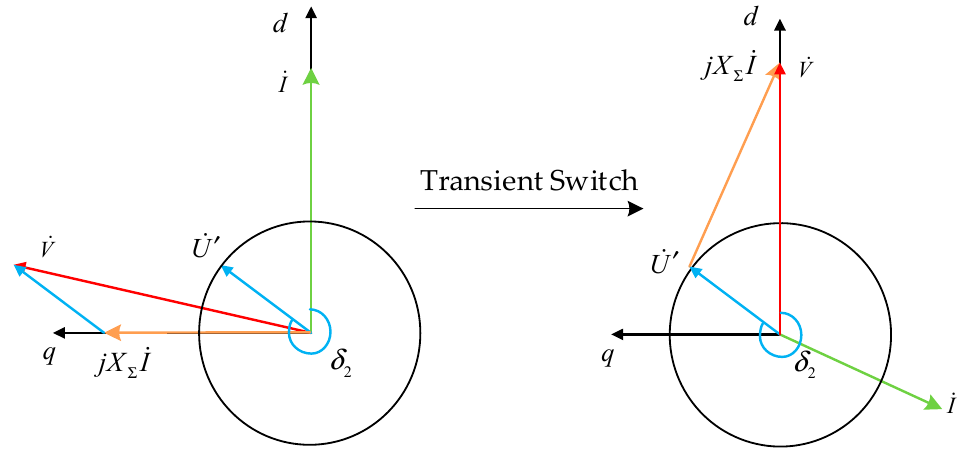
Figure 11. Vector diagram of transient switching process of current source and voltage source.